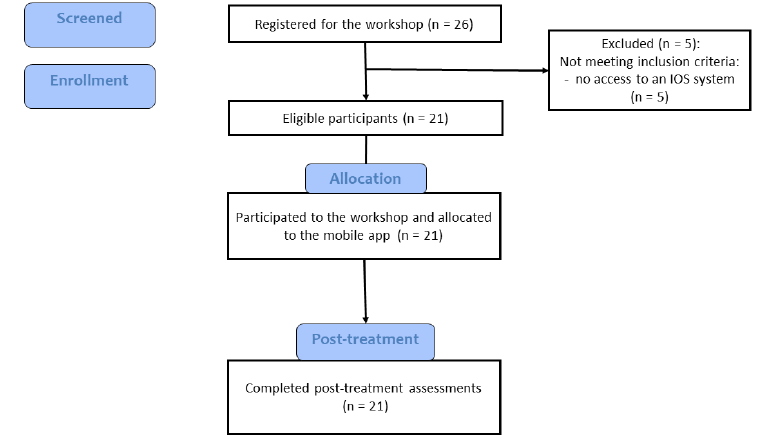
Figure 7. Flow chart of participants through the study.